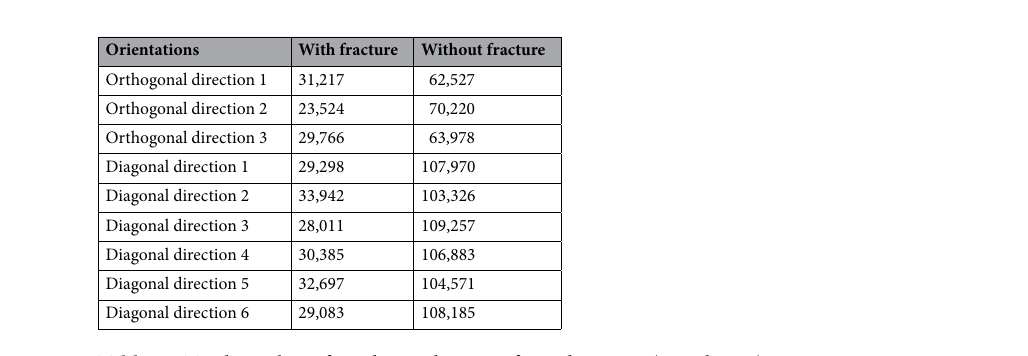
Figure 8. The 3D annotation method. ( a ) Annotated 3D bone surface data. ( b ) Annotation of completely displaced fracture ( F1 ). ( c ) Annotation of incompletely displaced fracture ( F2 ) or compression fracture ( F3 ).